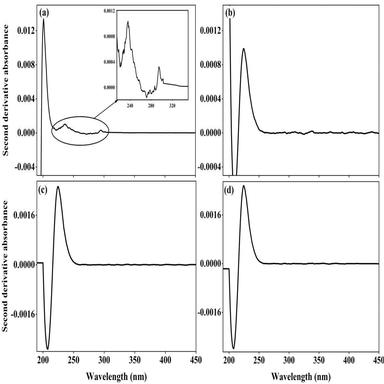
Representative UV second derivative spectra of different process units: (a) influent, (b) anoxia, (c) aeration, (d) filtration. Sampling date: November 12th, 2020. UV: ultraviolet.